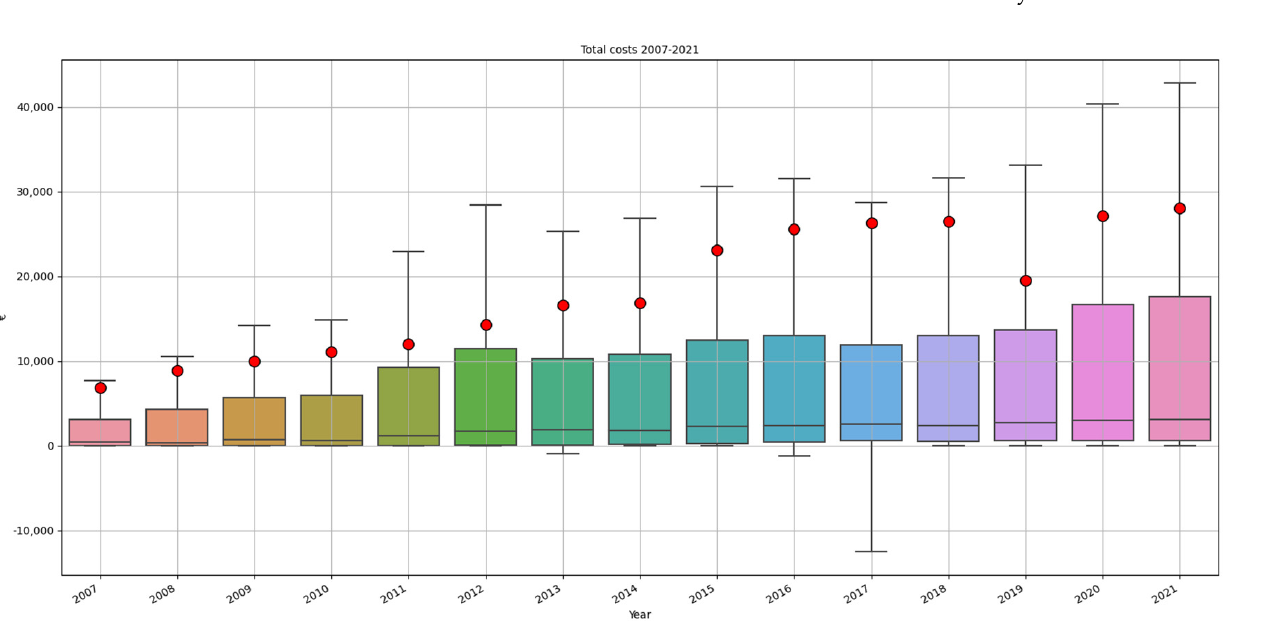
Figure 8. Mean, median, first and third quartile of the total costs per claim per year. The red dots indicate the mean costs, the black lines in the boxes the median costs.